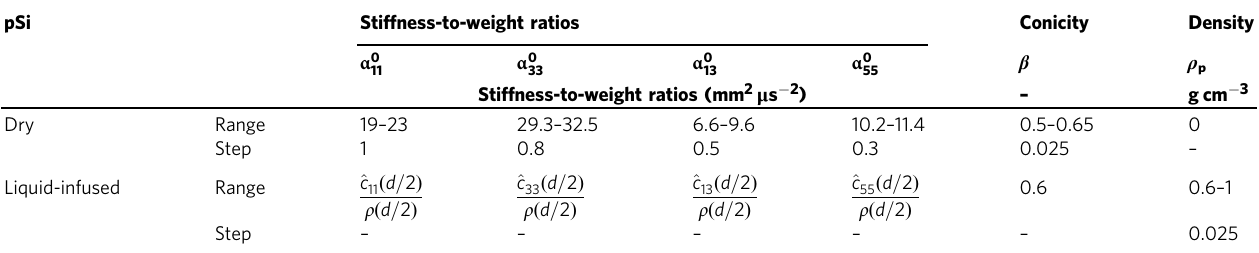
Table 1 Bounds of the model parameters Θ and their respective discretisation used to perform the inverse identi fi cation. pSi